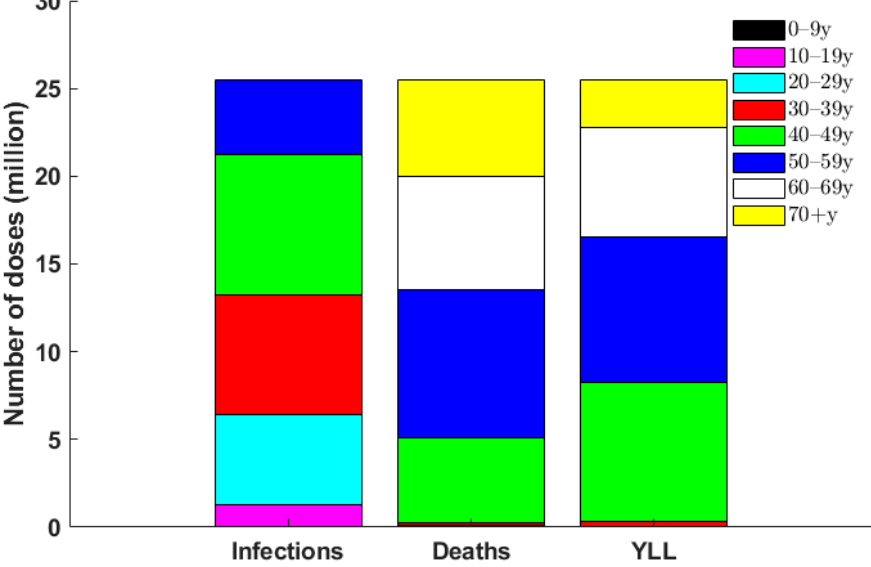
Figure 2. Number of vaccines optimally distributed to each age group from the 51 million available vaccine doses (i.e., doses to vaccinate 50% of the South Korean population) for each outcome measure.